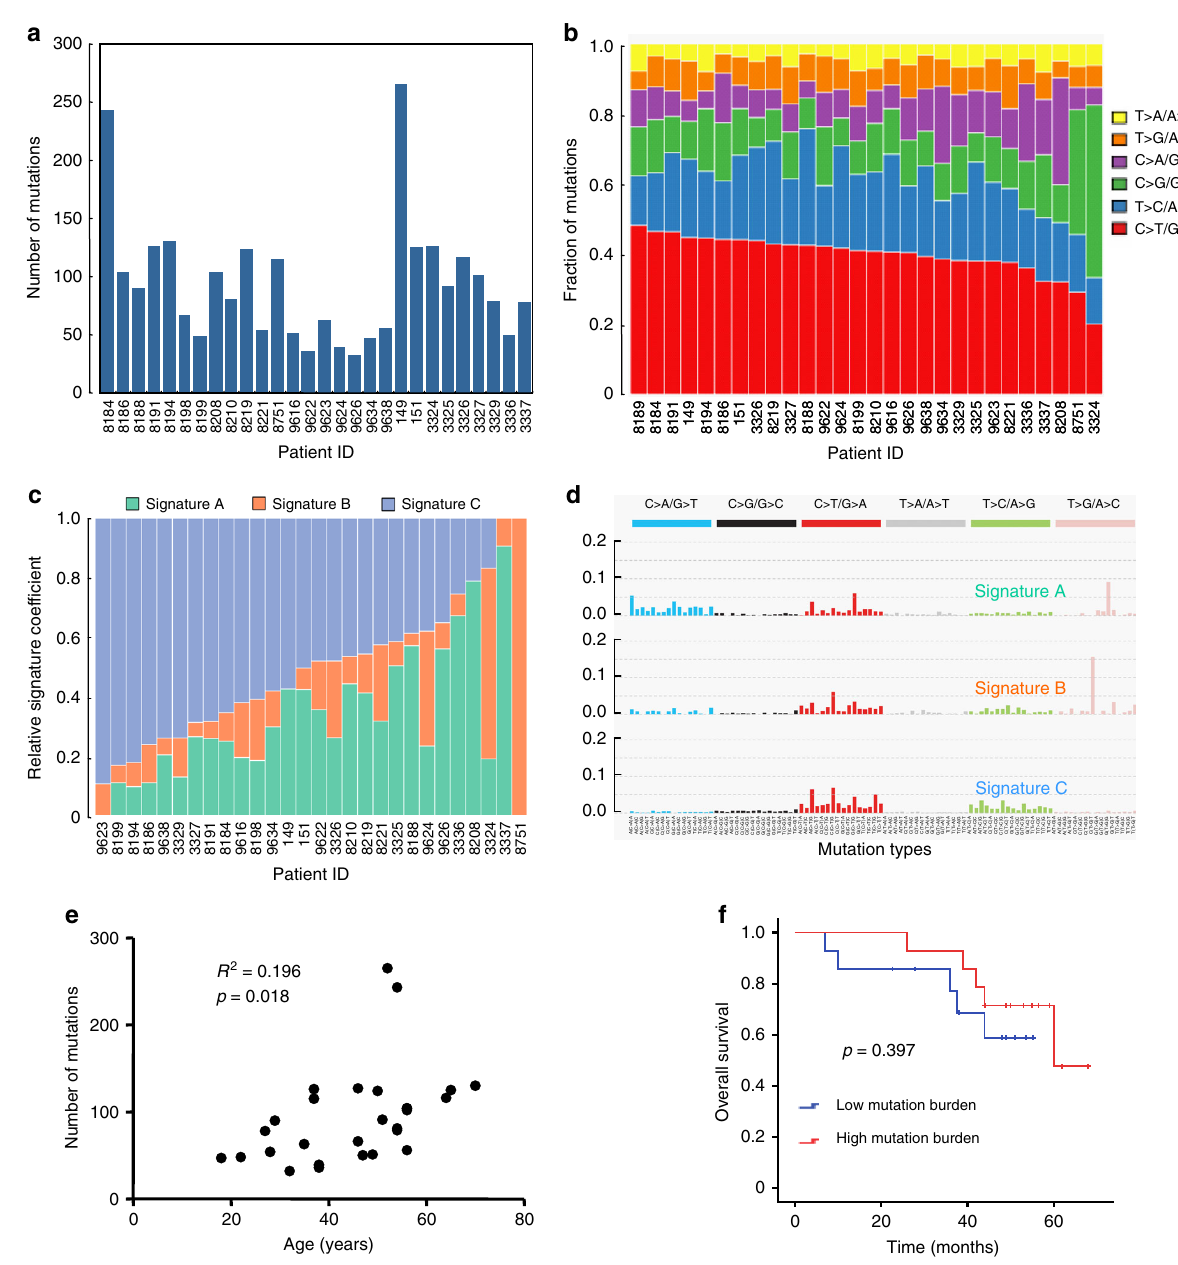
Fig. 1 Whole-exome sequencing in 28 patients with NKTCL. a The number and type of nonsilent somatic mutations identi fi ed by whole-exome sequencing. b The spectrum of mutations in NKTCL. c , d Three dominant signatures identi fi ed by combined nonnegative matrix factorization clustering and correlation in NKTCL, with 30 curated mutational signatures de fi ned by the COSMIC database. e The correlation analysis of nonsilent somatic mutations and the age of the NKTCL patients ( n = 28; R 2 = 0.196, P = 0.018). f The association of the somatic nonsilent mutation burden with overall survival in NKTCL (log-rank P